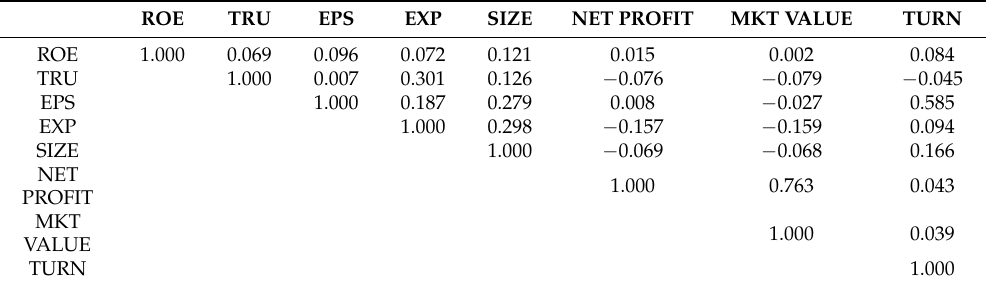
Table 3. Correlation